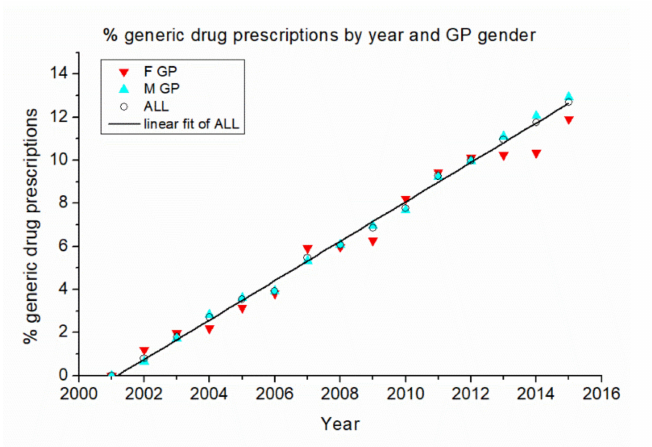
Figure 1. Percentage of generic drug prescriptions by year and GP gender. The black line is a linear fit of data referred to all GPs.